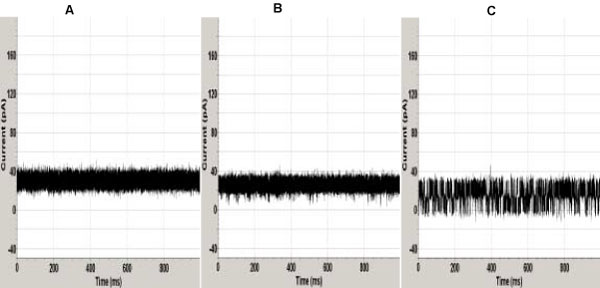
(A) 9GC DNA hairpin with 20 bp stem. (B) 9GC 20 bp stem with magnetic bead attached. (C) 9GC 20 bp stem with magnetic bead attached and driven by a laser beam chopped at 1 Hz. (From [7].)